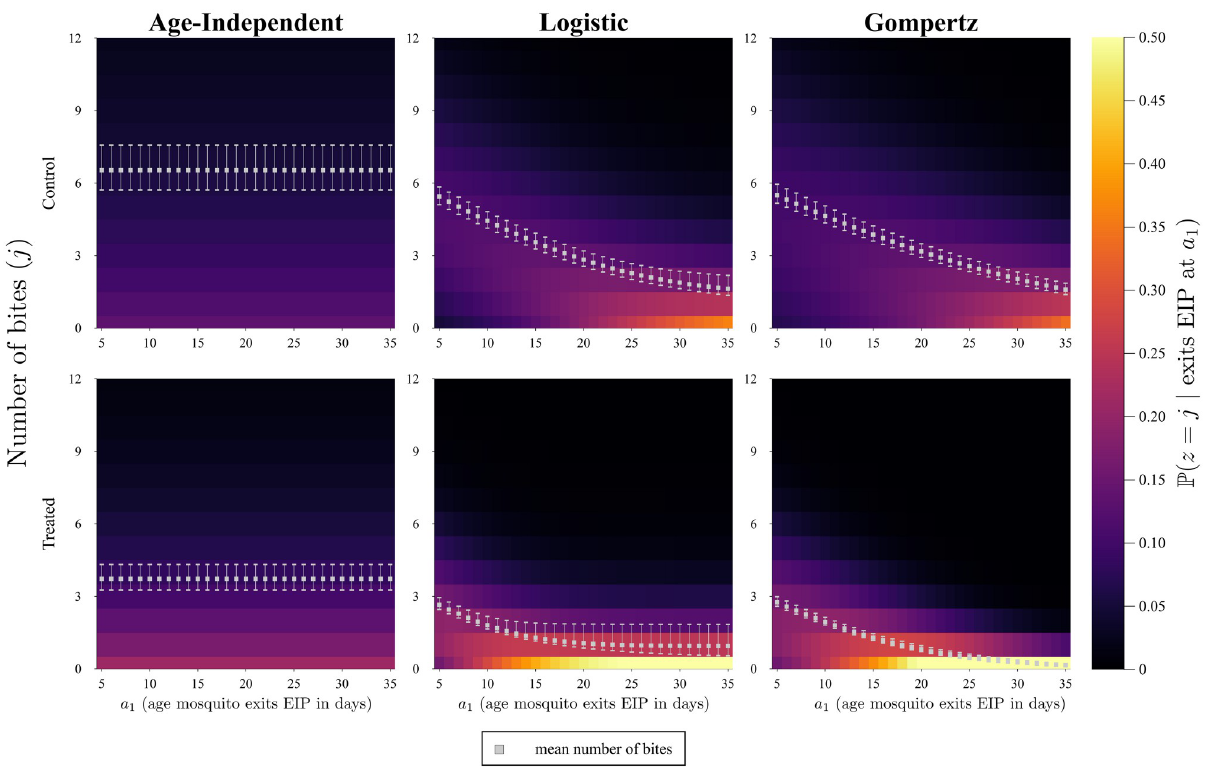
Fig 7. Heatmaps of the probability the number of bites is equal to some j given that the mosquito exits the extrinsic incubation period (EIP) at age a 1 . The heatmaps are obtained from the fitted parameters. The error bars on the mean markers represent the 95% confidence interval due to the propagated error for the fitted parameters using Monte Carlo simulations.